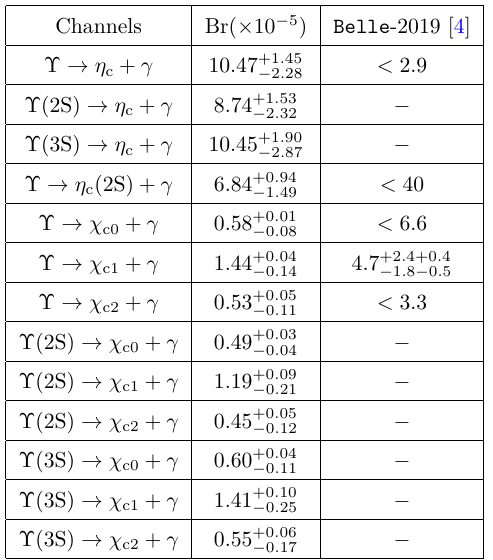
Table 6 . NRQCD predictions on the branching fraction of a vector bottomonium radiative decay into a charmonium. We choose m c = 1 . 483 GeV , m b = 4 . 580 GeV and evaluate the LDMEs through the BT potential model. The masses of the quarkonia are taken from PDG [59]. The second row represents the branching fractions up to NLO in α s , where the uncertainties originate from µ R - dependence and Γ . We display the experimental data from Belle [4] in the third Υ( nS )